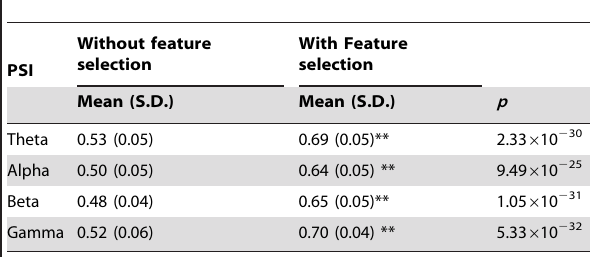
Table 6. Comparison of Classification Accuracy in Different Frequency Bands With and Without Feature Selection Base on Phase Synchronization Index (PSI).